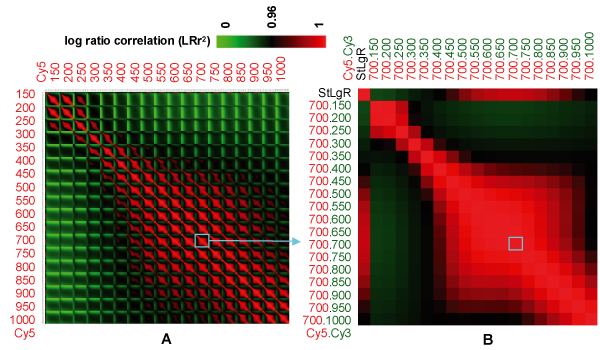
Reproducibility of log ratios. A: Correlation matrix for 324 pairs of Cy5/Cy3 gains; B: Correlation matrix for Cy5 gain at 700 V and 18 gains for Cy3. StLgR refers to the standard log ratios calculated from the spotted Cy5 and Cy3 concentrations on the scanner calibration slide.